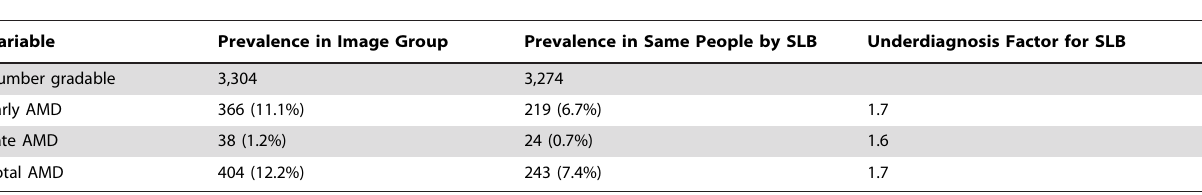
Table 4. Comparison of SLB and image groups.